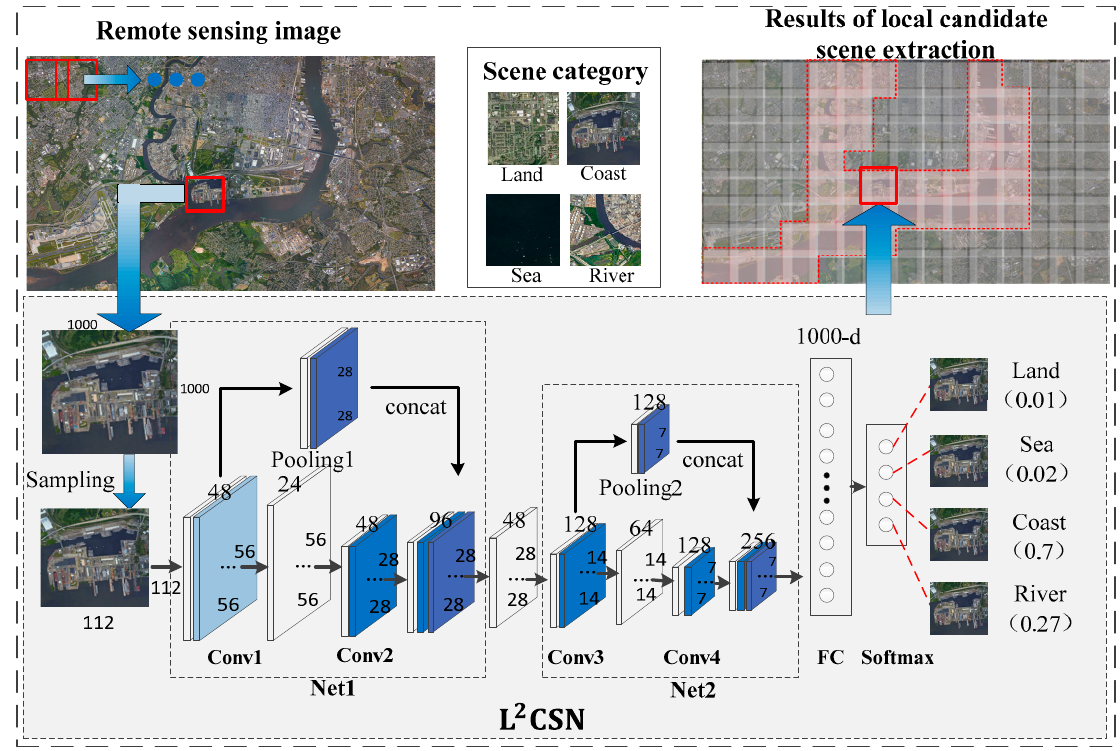
2 CSN Figure 2. The L (cid:2870) CSN architecture. Figure 2. The L